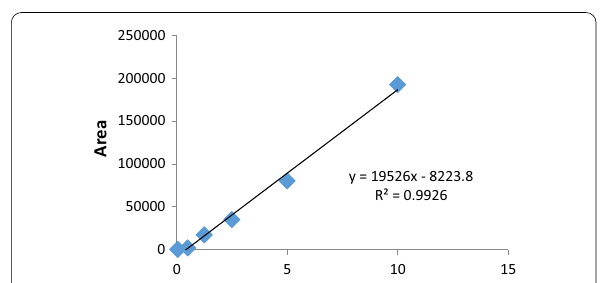
y = 19526x -8223.8 R² = 0.9926